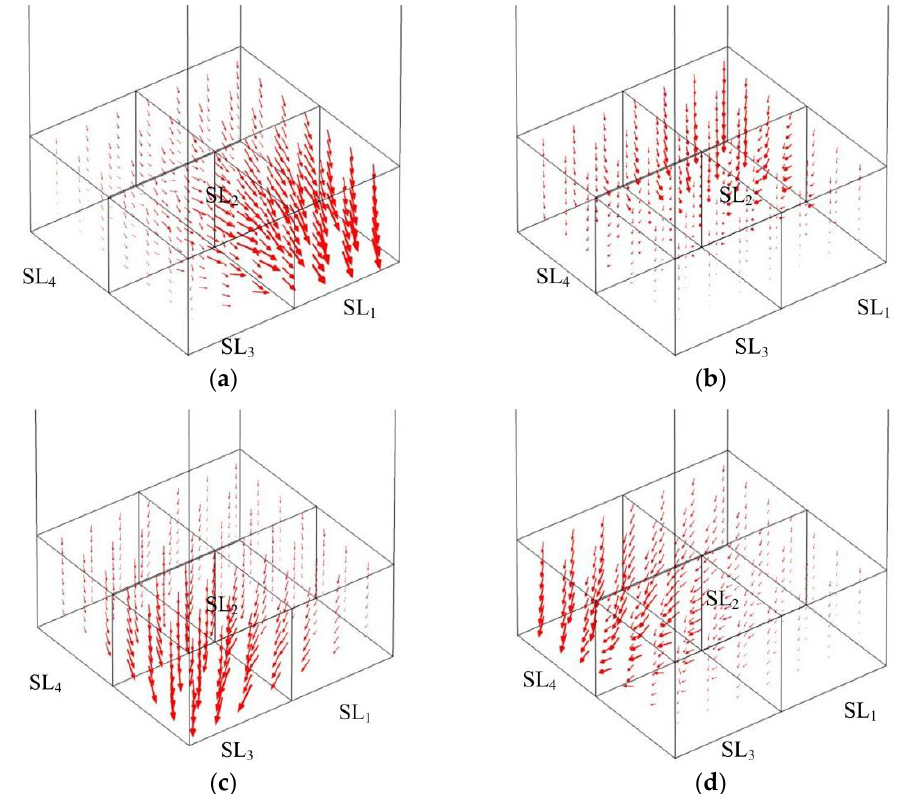
Figure 4. The acoustic intensity of parallel shunted loudspeaker array ( a ) at 100 Hz; ( b ) at 200 Hz; ( c ) at 300 Hz; ( d ) at 400 Hz.